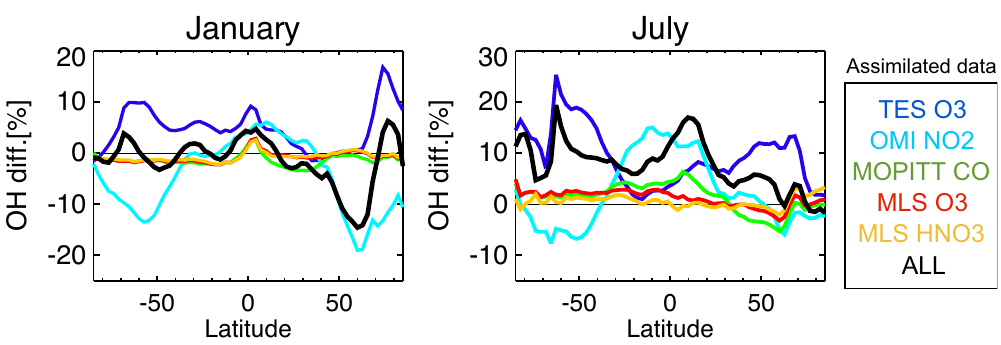
Fig. 4. Latitudinal distributions of the effect of data assimilation on the mean concentration of OH, averaged between 800 and 550hPa for 16–30 January 2007 (left) and 16–30 July 2007 (right). The percentage difference of the zonal mean concentration, averaged between 800 and 550hPa, between the assimilation runs and the control run is shown for six different assimilation runs; the full assimilation run (with all the data, black) and the five OSEs with TES O 3 data (marble), OMI NO 2 data (light blue), MOPITT CO data (green), MLS O 3 data (red), and MLS HNO 3 data (yellow). A positive (negative) value indicates that the assimilation run has a higher (lower) concentration than the control run.